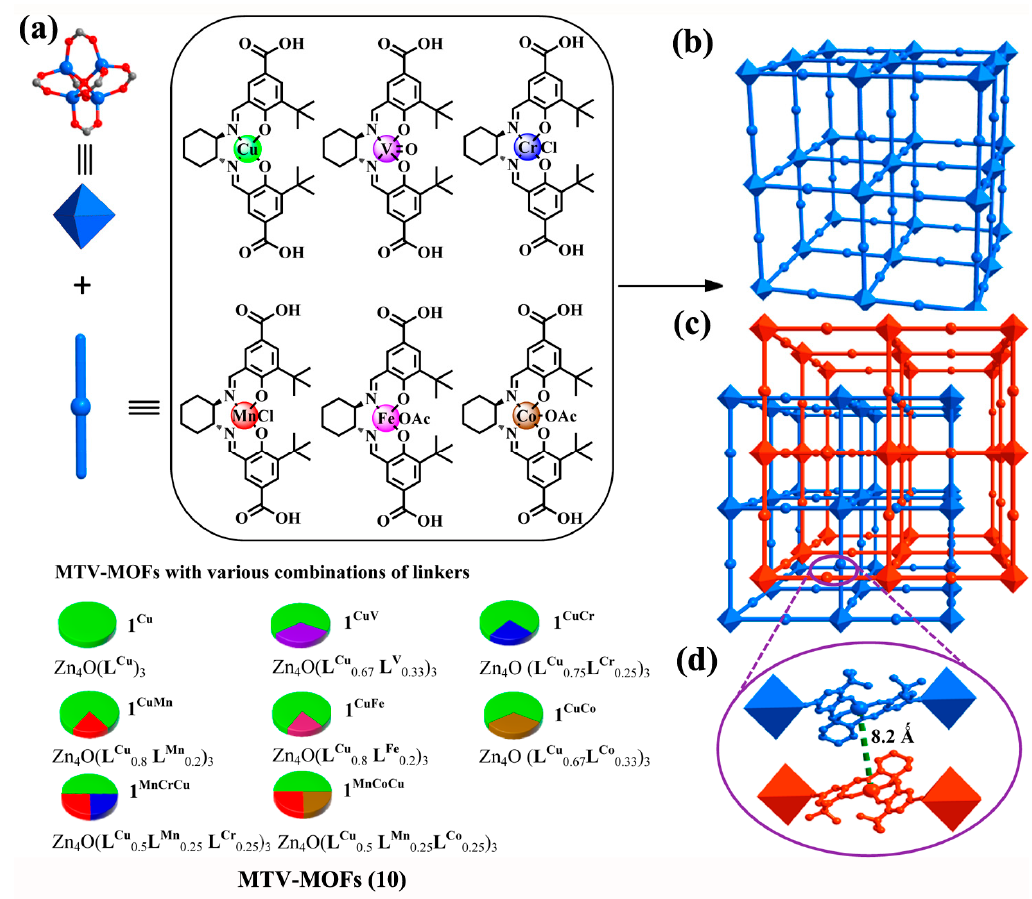
Figure 5. ( a ) Construction of MOF 10 Cu and corresponding multivariate (MTV)-MOFs 10 CuM and 10 CuMM ′ with different metallosalen linkers; ( b ) one three-dimensional (3D) unit of MOF 10 CuM ; ( c ) two-fold interpenetrating 10 Cu (red indicates the interpenetrated 3D network); ( d ) close-up view of two L 7Cu units brought into proximity to each other by 2-fold interpenetration. Reproduced from [65] with permission from the American Chemical Society.